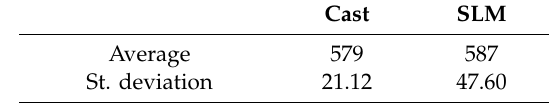
Table 4. Results of Vickers Hardness HV 0.1